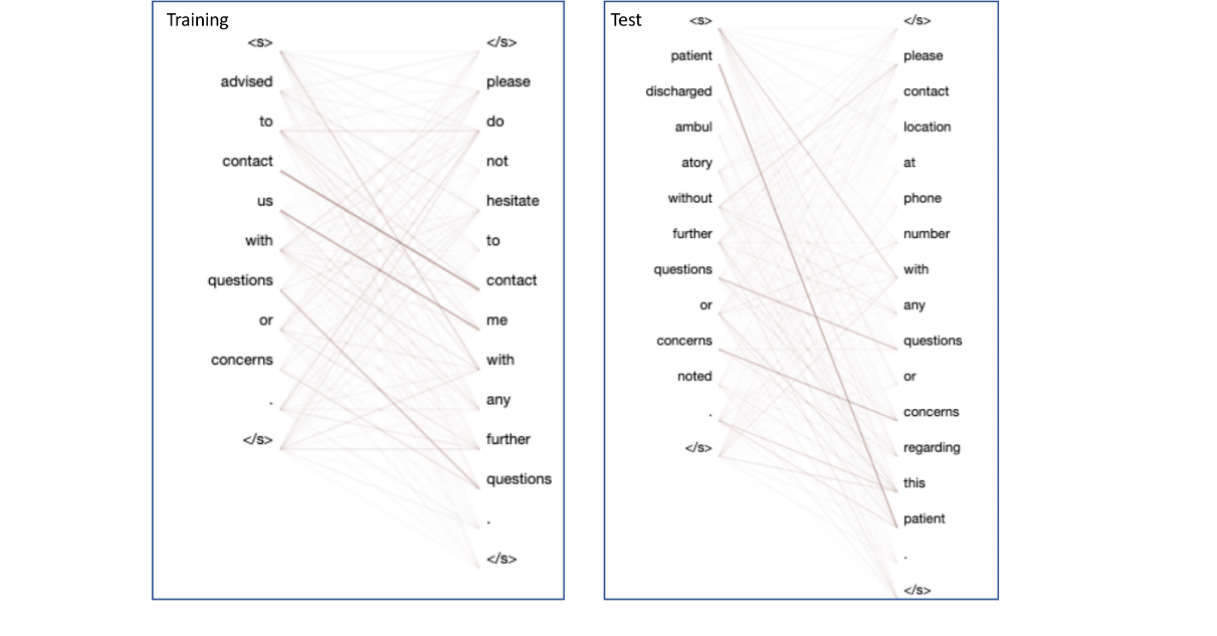
Figure 3. Transformer model attention visualization on two examples from STS-Clinic. STS: semantic textual